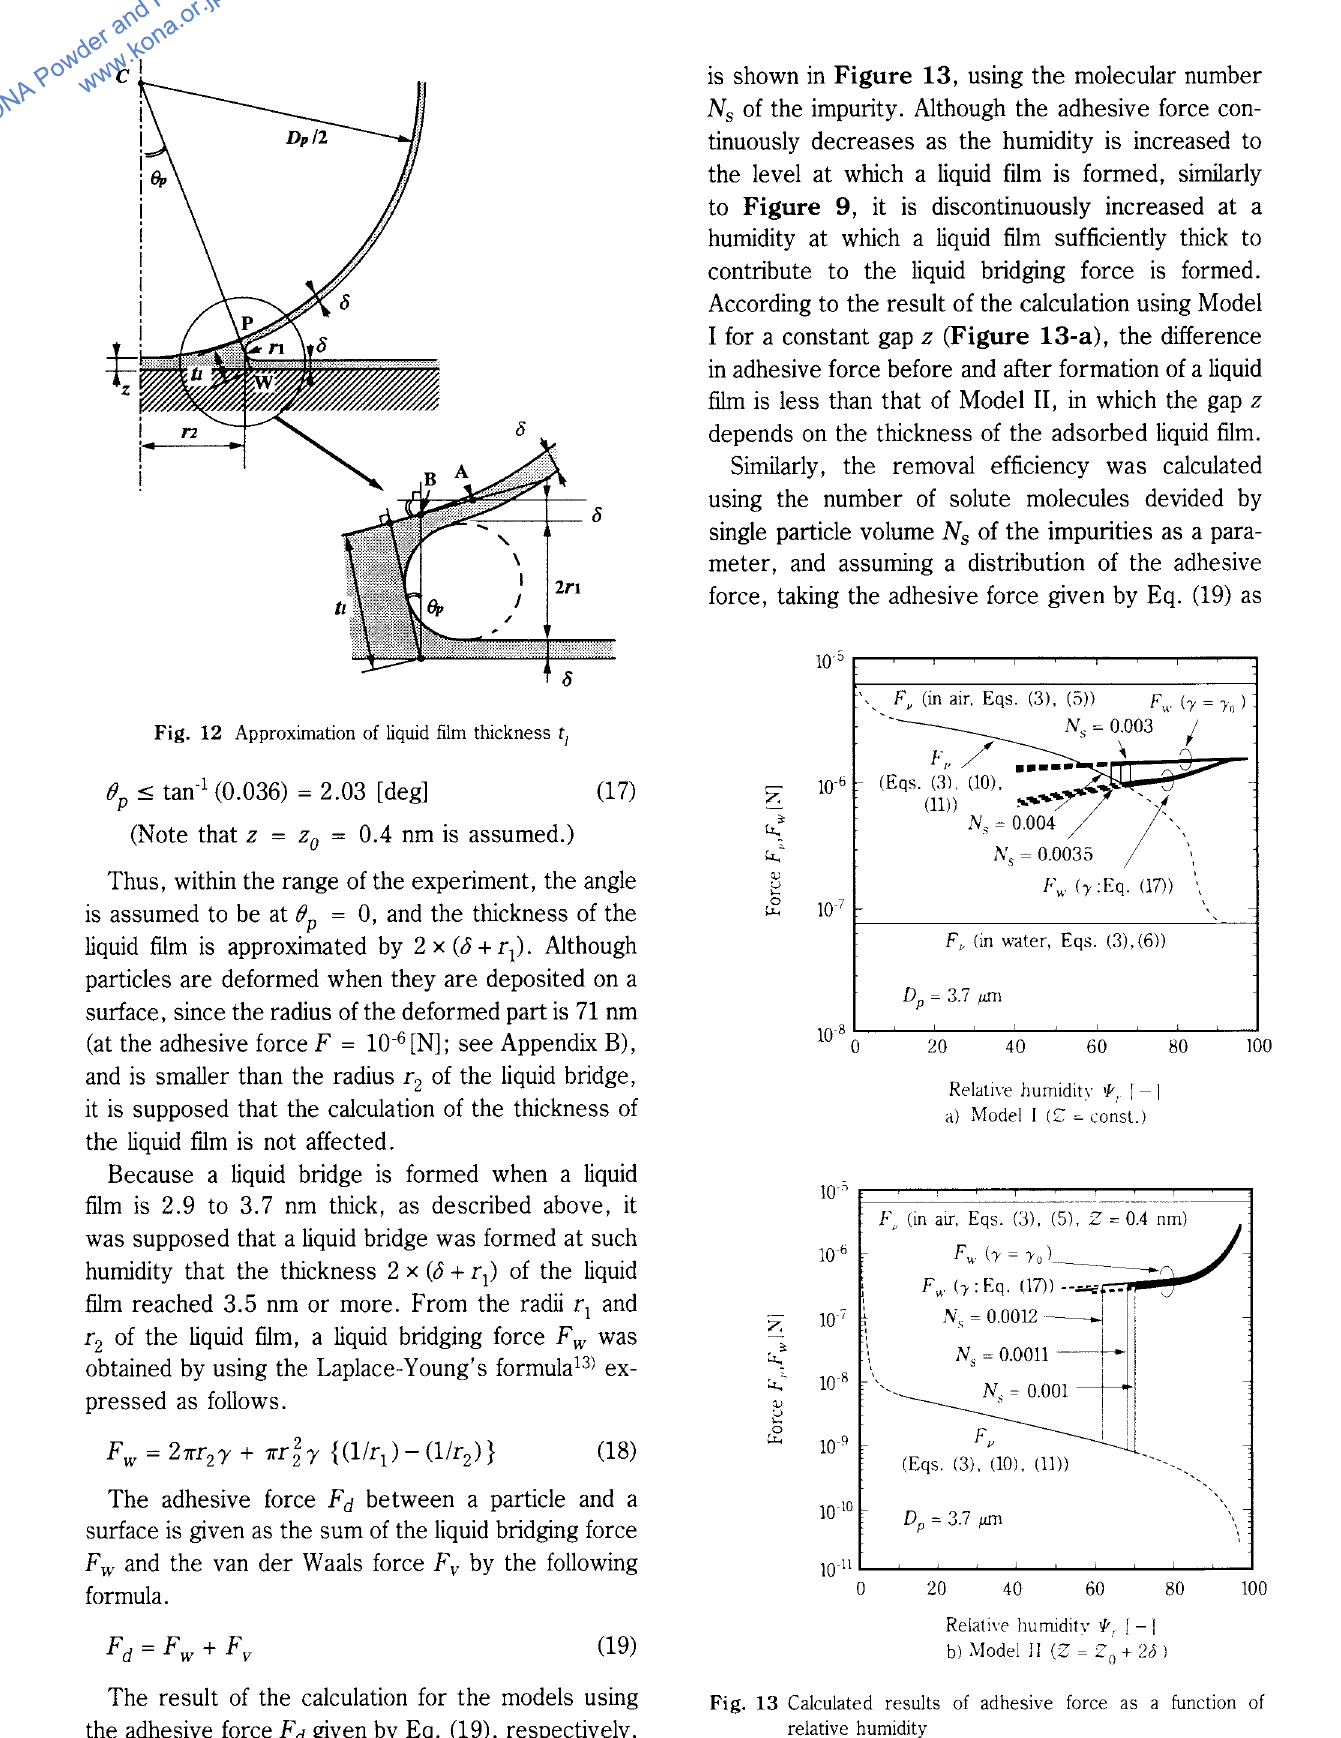
Fig. 13 Calculated results of adhesive force as a function of relative humidity